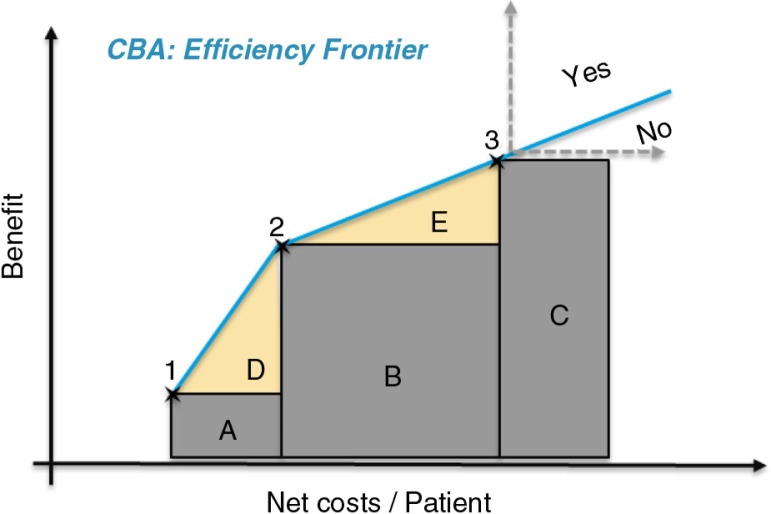
Cost–benefit assessment methodology (as explained by IQWIG) (14). The numbers 1-3 represent three existing therapies, and the blue line, the efficiency frontier, represents the willingness to pay, as illustrated by the adoption of more expensive, but more efficient therapies (i.e., from 1, via 2, to 3). New treatments that exceed the existing cost and benefit levels (beyond point 3) can be considered acceptable if the increase in net benefit and net costs are above the extension of the benefit frontier, that is, the extension of the willingness to pay from point 2 to 3, and beyond.